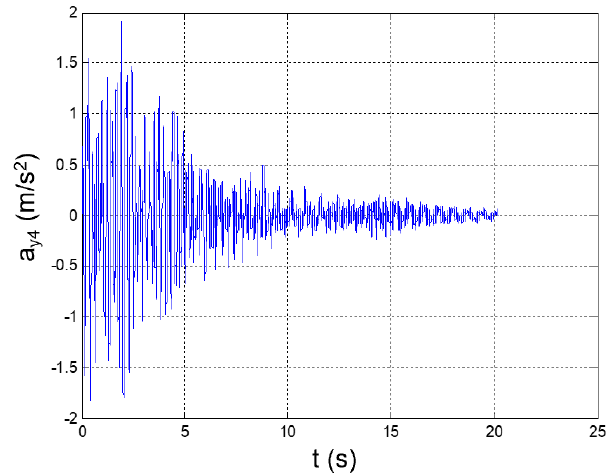
Figure 7. Seismic response, 3rd-floor acceleration (Node 47) with respect to the ground.